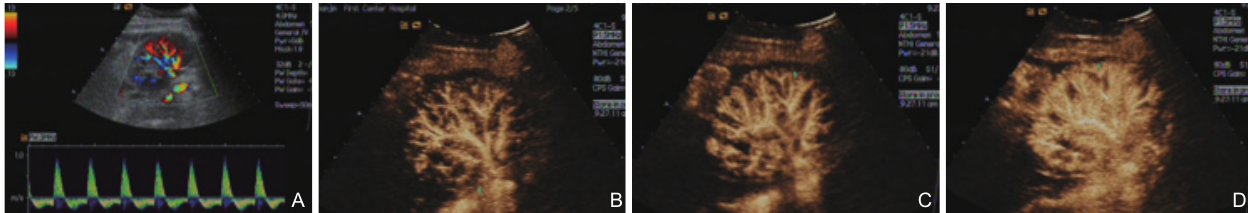
Figure 10 A 29-year-old man with 19-year diabetes and renal failure underwent combined pancreas-kidney transplantation. (A) At 19 days after transplantation with a creatinine of 556umol/L, Doppler ultrasound showed a high-resistance reverse flow of renal artery during diastole; (B-D) Contrast- enhanced ultrasound displayed apparent filling of the renal artery and its branches with no evident signs of venous return, consistent with renal vein